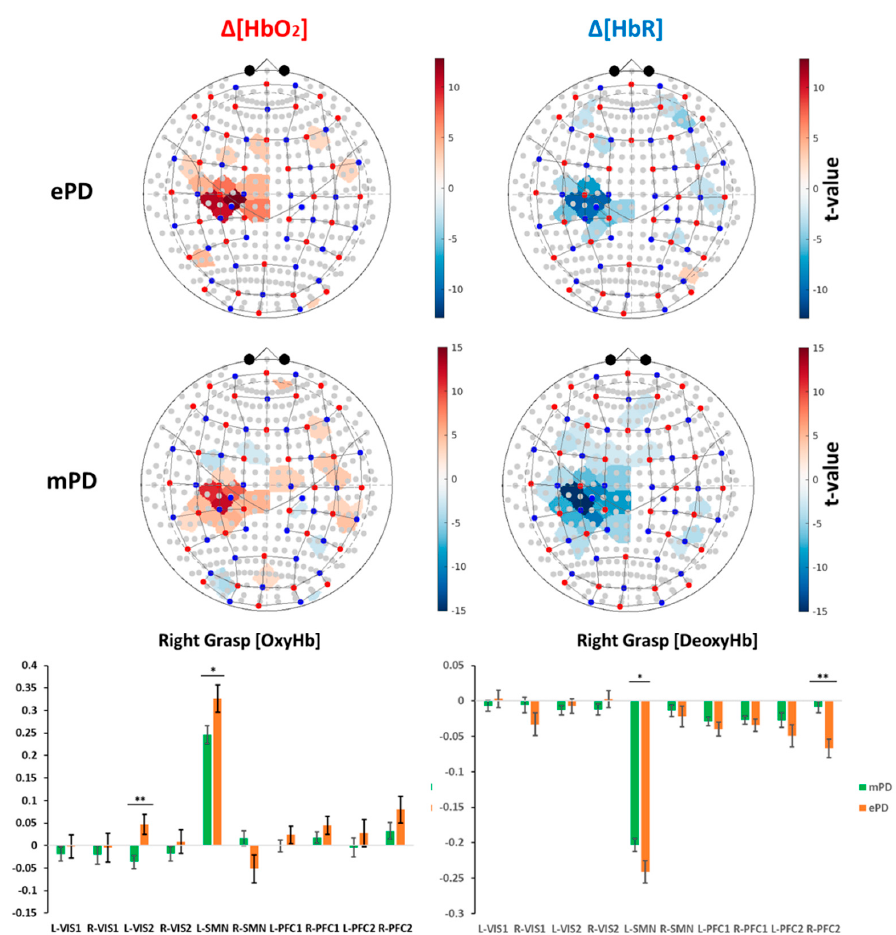
Figure 1. ( Top ) Significant group-level activation maps referring to right-grasp task. Results were corrected for multiple comparisons ( p FDR < 0.05). ( Bottom ) ROI analysis of group-level right-grasp task for the ePD and mPD groups: (*) significant contrasts not corrected for multiple comparisons ( p < 0.05); (**) significant contrasts corrected for multiple comparisons ( p FDR < 0.05). The correspond- ence between ROIs (i.e., horizontal axis) with functional and anatomical cortical areas is reported in Section 4.6.